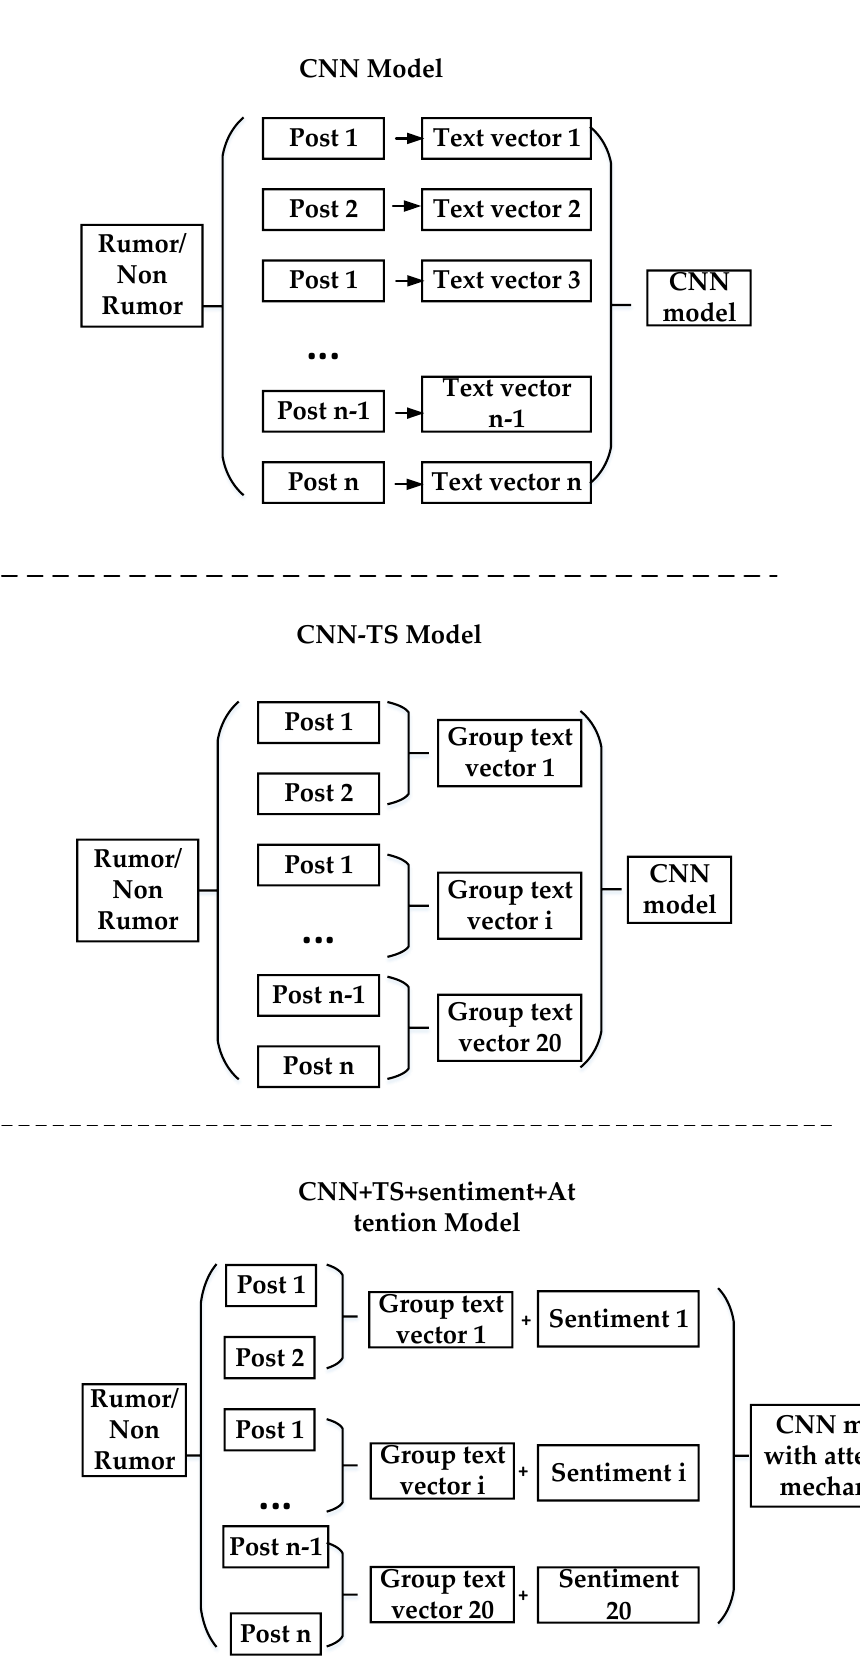
Figure 5. Input comparison of the CNN, CNN-TS, CNN-TS + Sentiment + Attention. Table 5. Comparison of parameters of the rumor detection models.